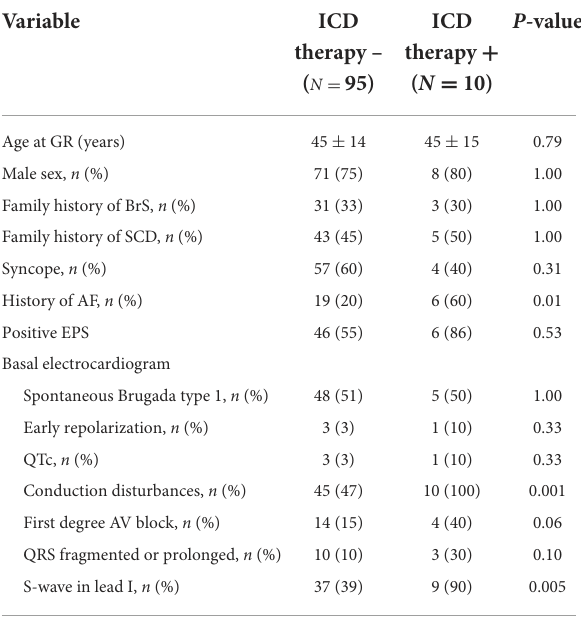
TABLE 2 Baseline clinical and electrocardiographic findings according to late appropriate ICD